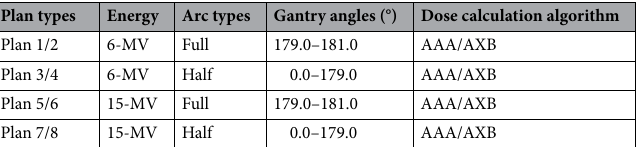
Table 1. Planning parameters volumetric modulation arc therapy (VMAT)